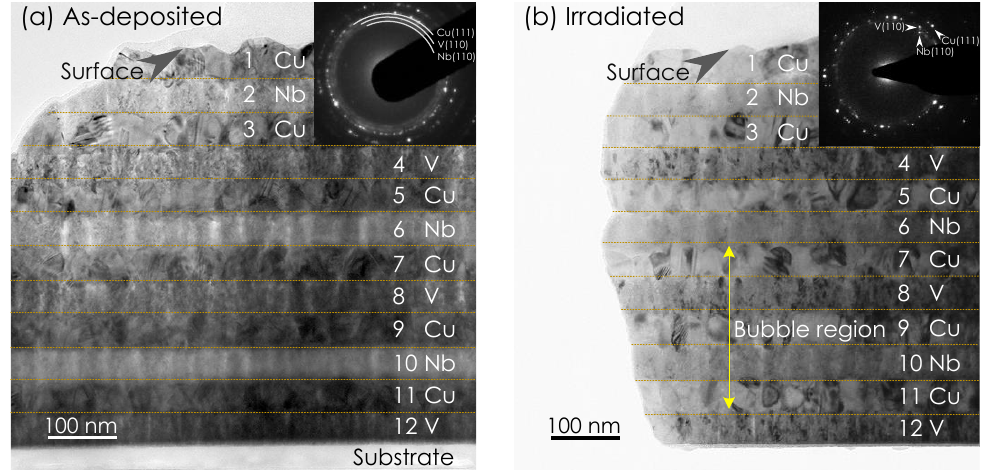
Figure 2. The bright-field XTEM images and corresponding SAED images of Cu-Nb-Cu-V 48 nm NMMCs in conditions of ( a ) as-deposited, ( b ) irradiated at room temperature with a dose of 6 × 10 16 ions / cm 2 at under-focused condition. In ( b ), bubbles are observed in the region of 7th to 11th layers and called as “Bubble region”.